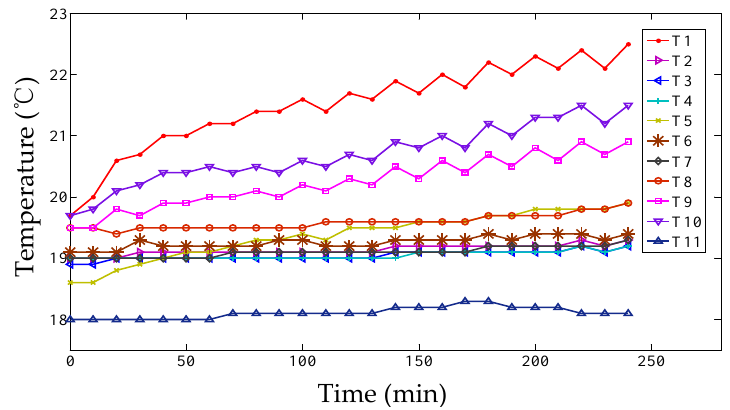
Time (min) Figure 15. Temperatures of 11 temperature sensors of experiment Figure 15. Temperatures of 11 temperature sensors of experiment II.